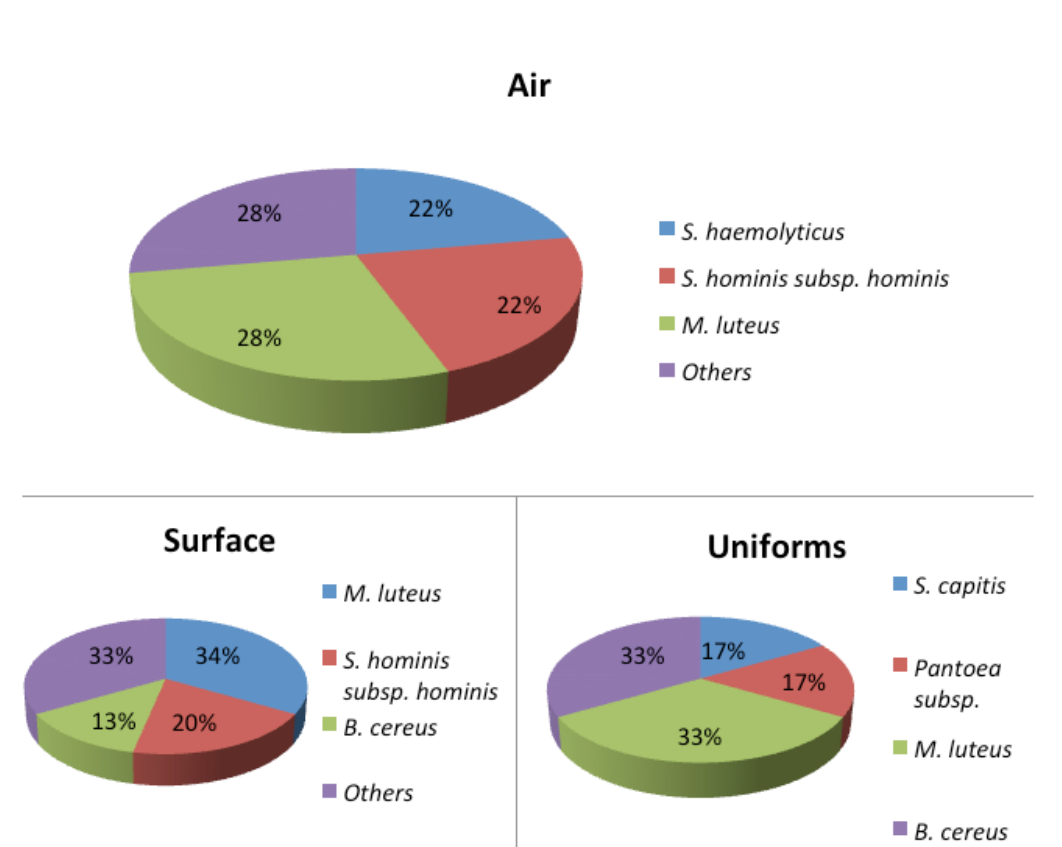
FIGURE 7 – Microorganisms identified in air, surface and uniforms samples of Post-surgical rest room (PSRR) – Hospital